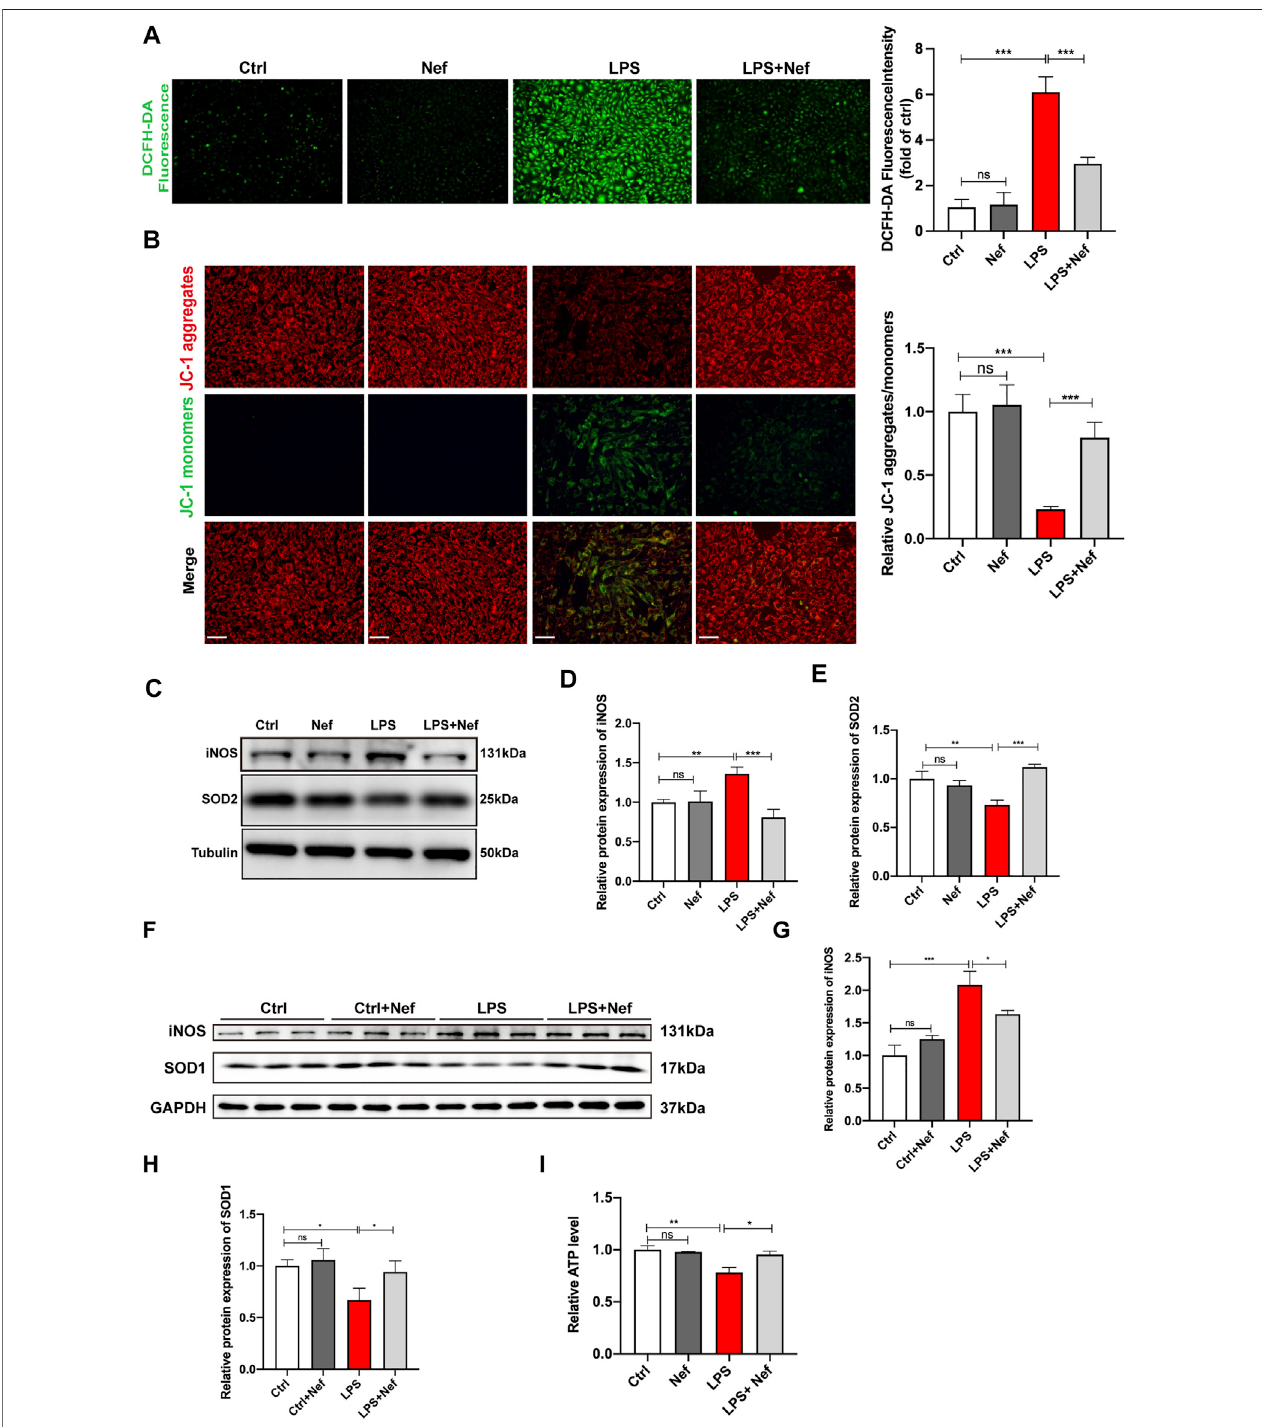
FIGURE 5 | Neferine reduced the production of reactive oxygen species (ROS) and prevented mitochondrial dysfunction. (A) DCFH-DA staining was used to evaluate the intracellular ROS level in H9c2 cells. Fluorescence intensity was measured. Scale bar, 50 μ m. (B) Representative images of JC-1 staining in LPS-induced H9c2cells.Fluorescenceintensitywasmeasured.Scalebar,50 μ m. (C – E) Westernblotanalysisanddensitometricquanti fi cationofSOD2andiNOSproteinexpression in H9c2 cells. (F) SOD1 and iNOS protein expression levels in septic mice were detected by Western blot ( n = 6). (G,H) Densitometric quanti fi cation of SOD1 and iNOS protein expression levels. (I) ATPlevels inH9c2 cells were analyzed. All dataare expressed as mean ±SD. All experiments wererepeated at least three times.* p < 0.05, ** p < 0.01, *** p < 0.001; ns: no signi fi cant difference; DCFH-DA, 2 ′ -7 ′ dichloro fl uorescein diacetate.